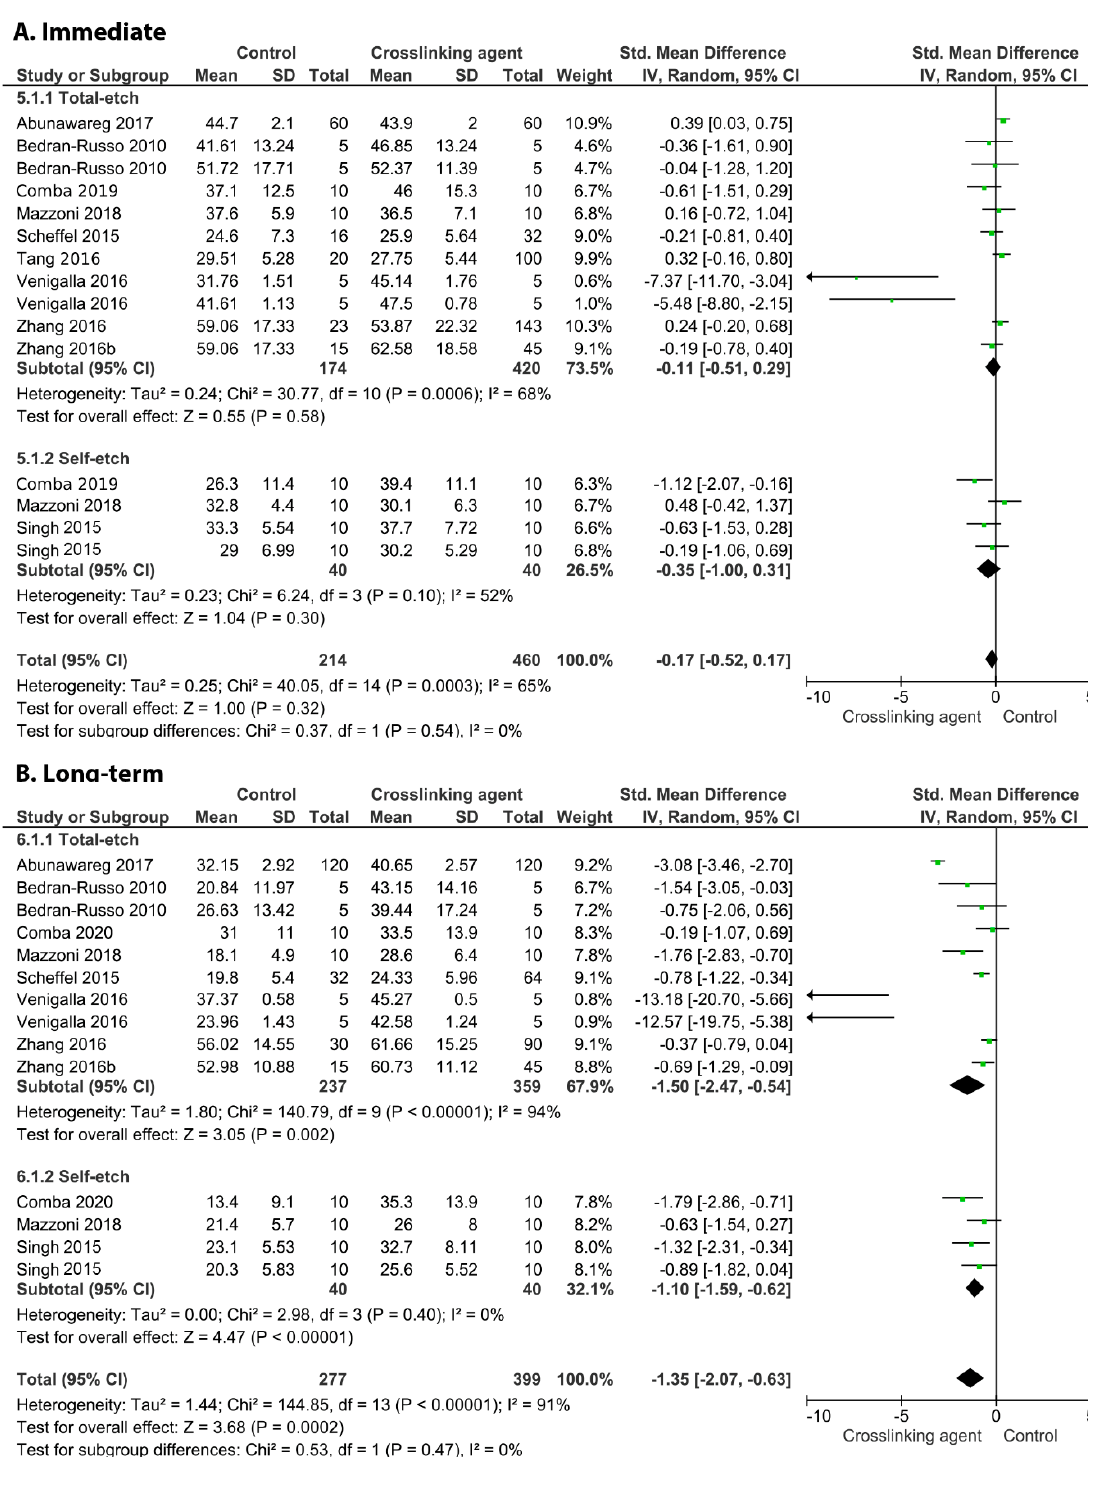
Figure 4. Forest plot of the immediate ( A ) and long-term ( B ) bond strength comparison between the carbodiimide crosslinking agent and the control according to the adhesive used [60,82,83,85,90,97,106,109,115].